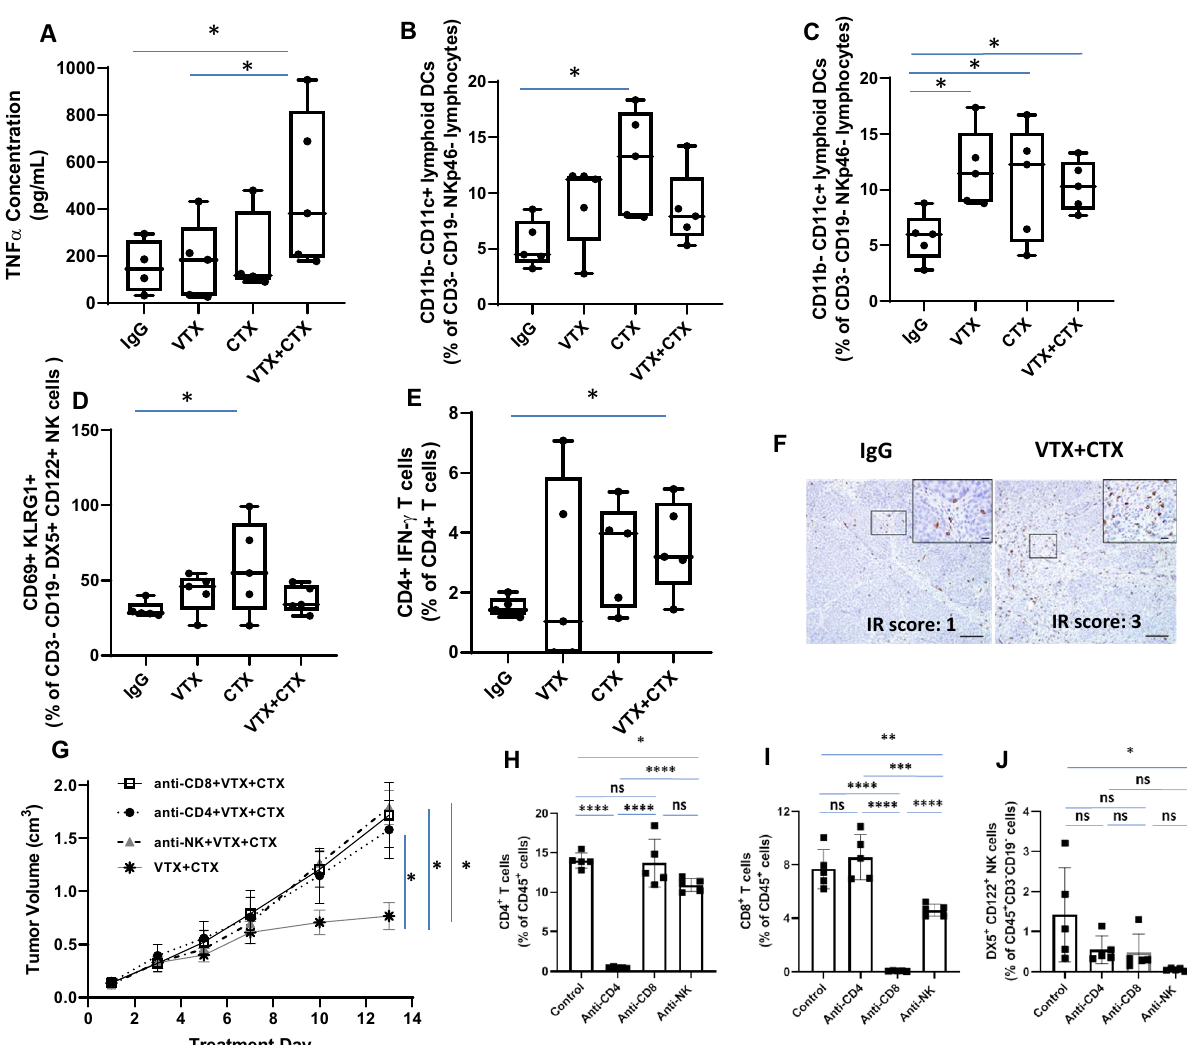
Figure 5. VTX-2337 and Cetuximab increase immune cell infiltration. Blood, tumors and spleens were harvested from a subset of mice (n = 4–5) one day after drug treatment and analyzed for serum concentrations of TNFα ( A ), and tumor ( B ) and splenic ( C ) lymphoid DCs, CD69 + NK cells ( D ) and IFNγ + CD4 + T cells ( E ) using flow cytometry. ( F ) Images represent CD8 immunostaining in control (left image) and VTX + CTX (right image)-treated tumors. Bars = 100 µm (inset bars = 20 µm). ( G – J ) Female BALB/c mice (n = 9–10 mice/group) bearing TUBO-hEGFR tumors were treated with VTX in combination with CTX with or without anti-CD4, anti-CD8 or anti-asialo-GM1 (anti-NK) and tumor growth ( G ) was measured. Spleens were analyzed by flow cytometry for validation of CD4 + T cell (H), CD8 + T cell ( I ) and NK cell ( J ) depletion. *p < 0.05, **p <